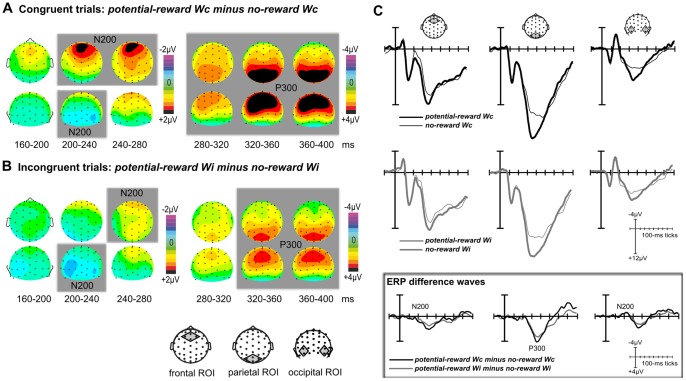
Effects of reward on early stimulus processing.(A) Averaged ERP distribution maps of the difference between congruent potential-reward and congruent no-reward trials reveal reward-induced modulations of the frontal N200, the parietal P300, and the occiptal N200 components. (B) In incongruent trials (collapsed across the two different word-meaning types Wi0 and Wi$), the reward-induced positive-polarity effects were substantially attenuated. Gray-shaded areas indicate significant mean-amplitude differences in the respective regions of interest (ROIs; p-values<.05). (C) ERP waveforms for each condition as well as the respective ERP difference waves are shown for selected ROIs (averaged across channels).